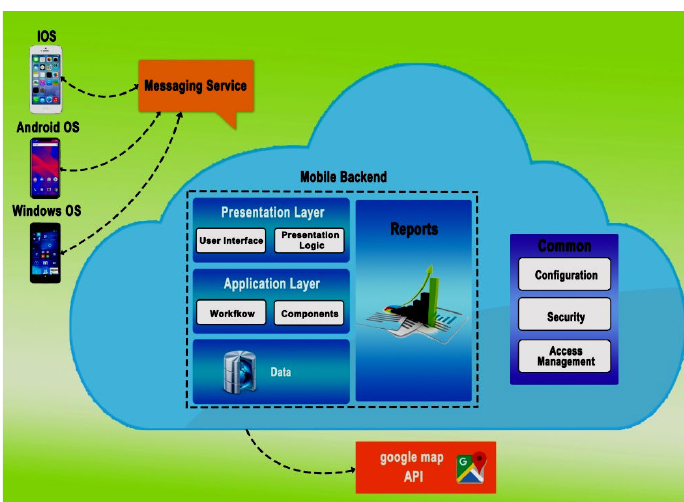
Figure 1. Mobile Application